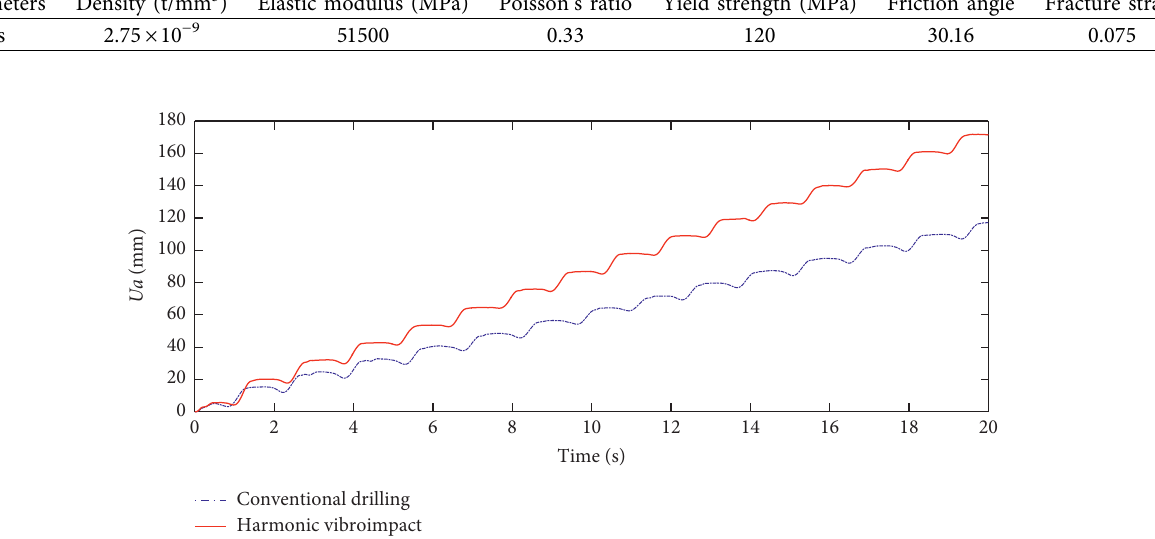
Figure 9: Time-history curves of progression under different drilling